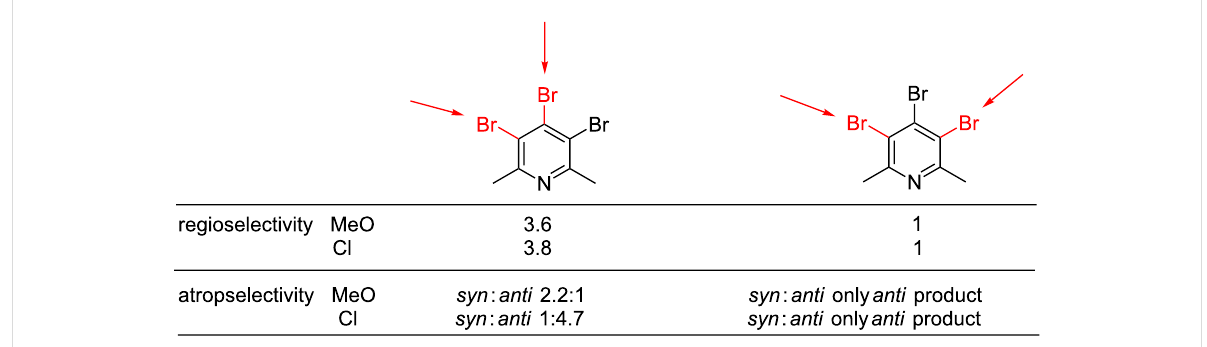
Figure 6: Summary of results for coupling with ortho -substituted phenylboronic acid for diaryl products.